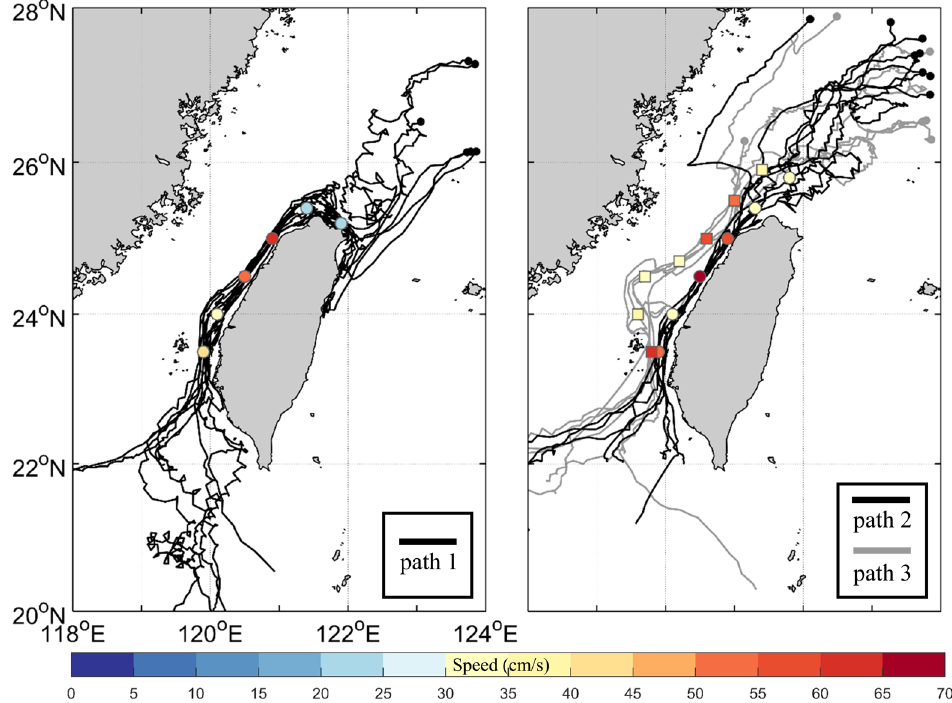
Figure 5. Trajectories of several satellite-tracked drifters that drifted clockwise around Taiwan. The black and gray circles represent the drifter destinations. The colored patches represent the average speeds of the drifting paths.